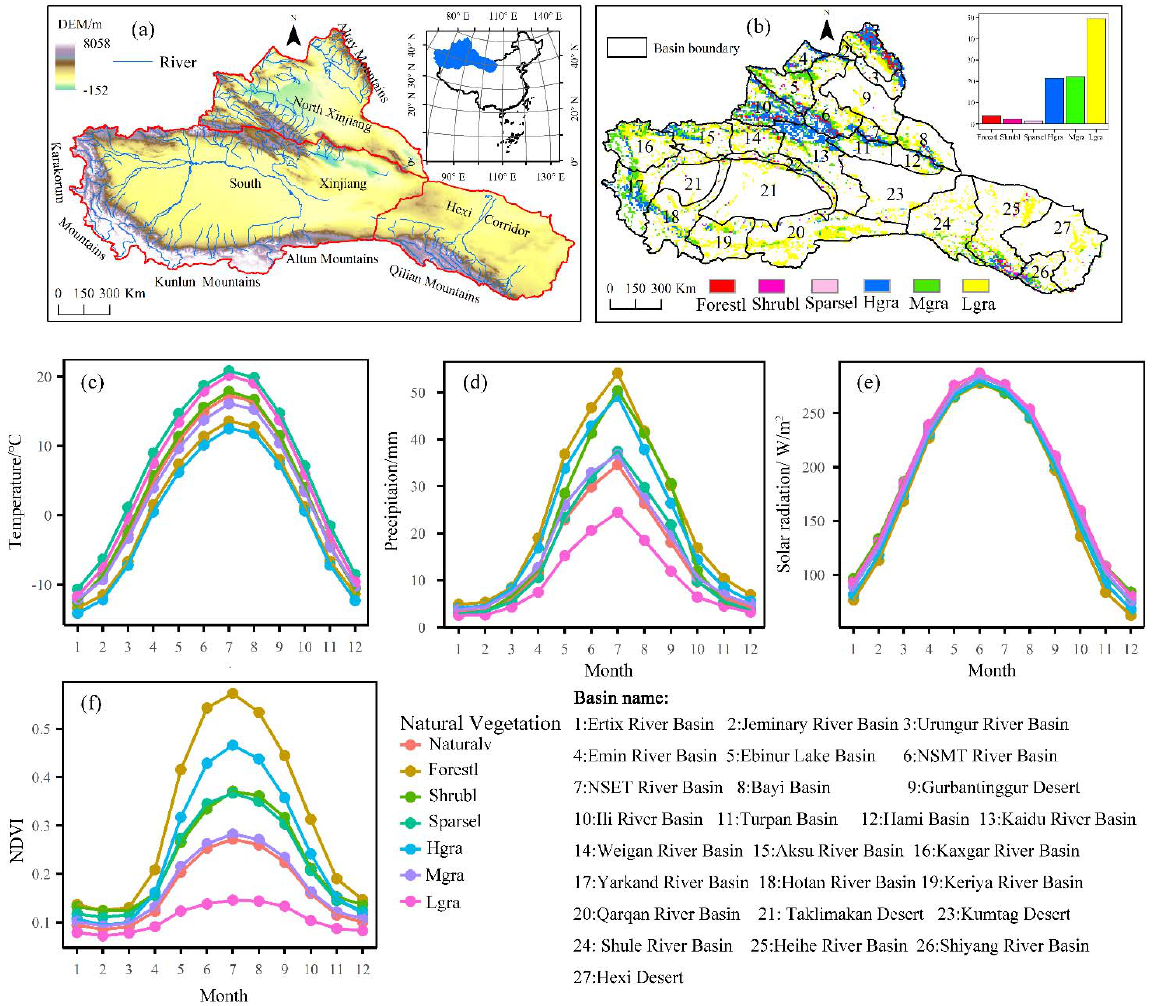
Figure 1. Topographic distribution ( a ), vegetation type distribution ( b ), monthly mean temperature ( c ), precipitation ( d ), solar radiation ( e ), and Normalized Difference Vegetation Index (NDVI) ( f ) for natural vegetation in the arid region of northwestern China (Naturalv—Natural vegetation; Forestl—forested land; Shrubl—shrub land; Sparsel—sparse forest land; Hgra—High − coverage grassland; Mgra—Medium − coverage grassland; Lgra—Low − coverage grassland).